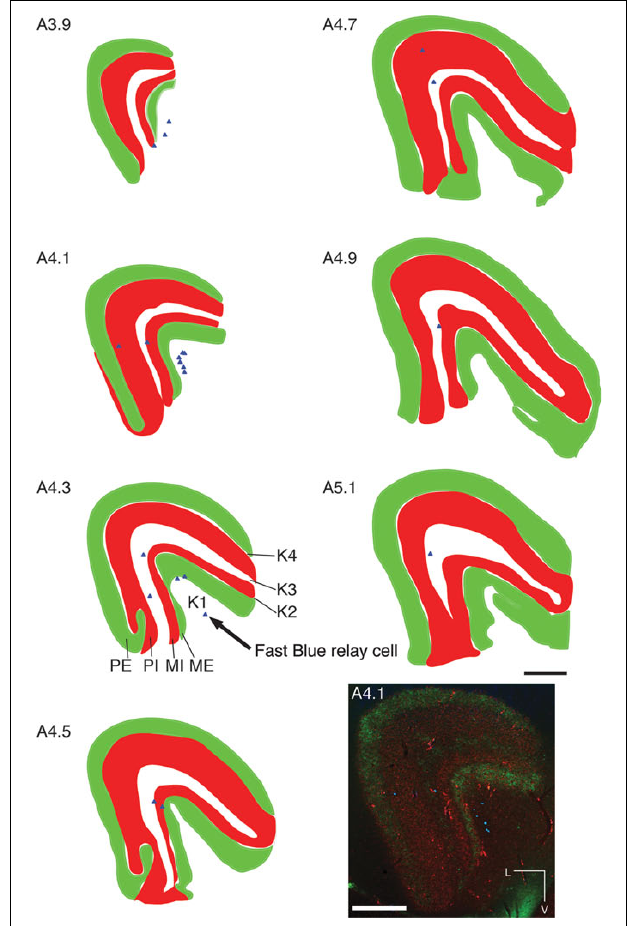
FIGURE 7 | Distribution of labeled area MT relay cells throughout the layers of the left LGN. Digitized line drawings of the LGN and its layers in coronal sections (Case NM58; 200 µm interval), demonstrating the distribution of ipsilateral (dark red) and contralateral (light green) terminal fi elds in the magnocellular and parvocellular and koniocellular layers (white) in addition to the area MT relay cells (blue triangles), seen primarily in the medial sections of the LGN and in the koniocellular layers (K1 and K3). Sections are presented in sequence along the anteroposterior axis from at the most posterior (A 3.9 mm) to the most anterior section (A 5.1 mm). Anteroposterior level 4.1 is reproduced at the bottom right to illustrate the pattern of labeling seen in the LGN used to create the line drawings. Adjacent sections reacted for calbindin-D28k, NNF and Nissl substance were used to delimit the LGN laminae. L, lateral; V, ventral; scale bar = 500 µm.